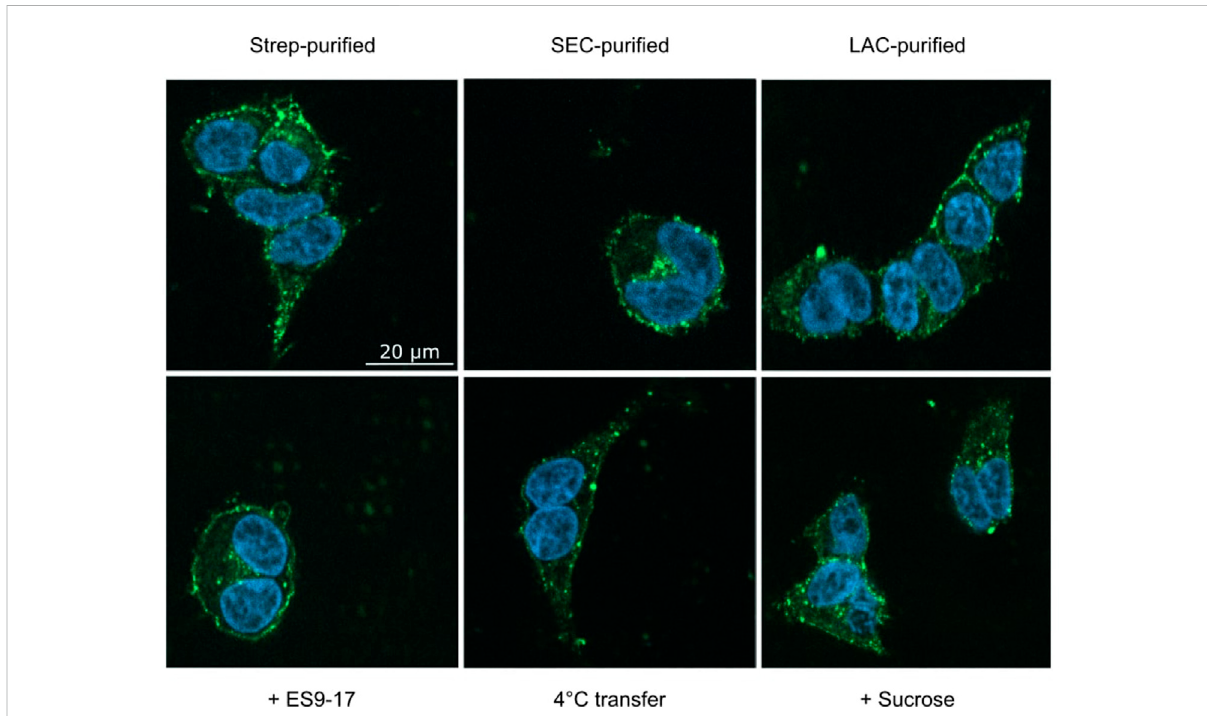
FIGURE 9 Analysis of cluster formation of transferred ETB-mNG. ETB-mNG/ND particles were puri fi ed either (i) via the C-terminal Strep-tag of the receptor, (ii) via the Strep-tag and subsequent SEC, or (iii) via LAC by using immobilized 4Ala-ET-1-biotin. ETB-mNG was then transferred into HEK293T cells at standard conditions and representative fl uorescence images of the cells were taken. Lower panel: Effects of addition of the endocytosis inhibitors ES9-17 (30 µM) or sucrose (0.45 M) and of performing the transfer at 4 ° C on the cluster formation of Strep-puri fi ed